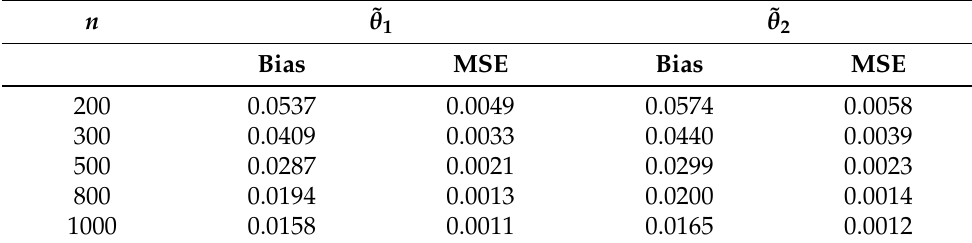
Table 5. The bias and MSEs of BEs for θ 1 = θ 2 = 0.05.